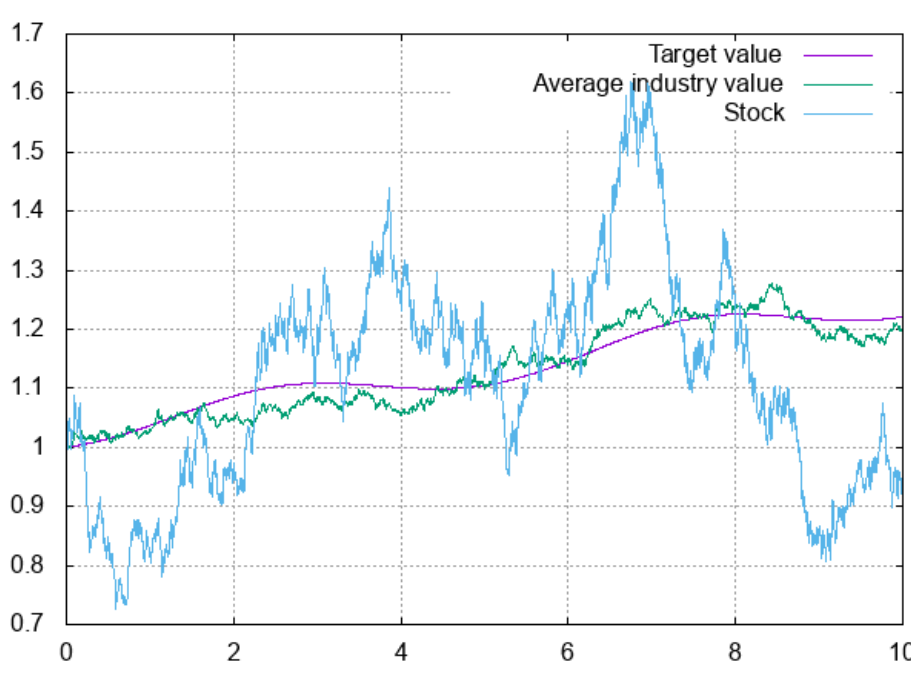
Figure 2. Market and one stock, mean reversion 1. Similar behavior is observed to the mean reversion 5 case, but the stock and market take longer to return to the underlying deterministic